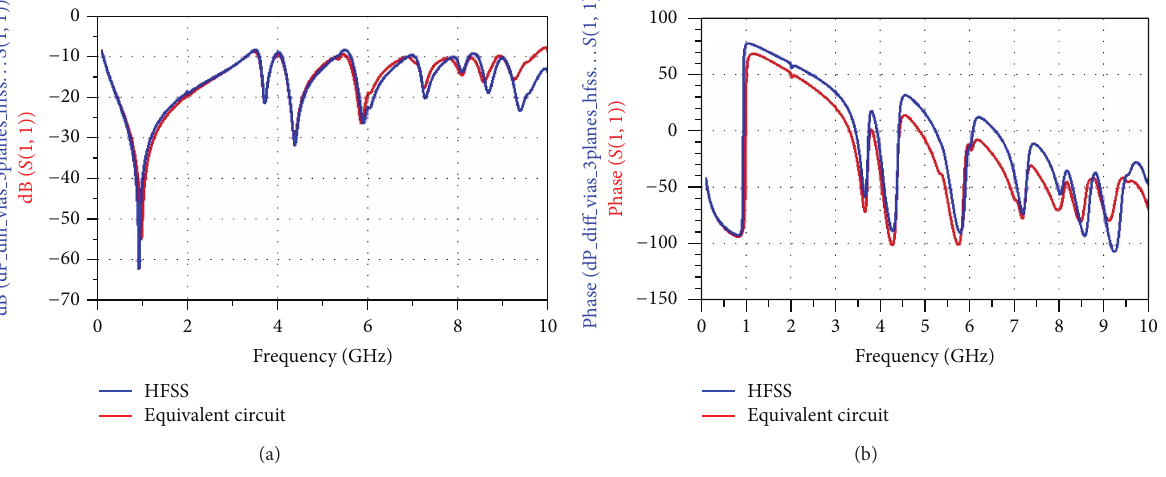
Figure 24: 𝑆 11 of differential vias in multilayer: (a) amplitude; (b) phase.